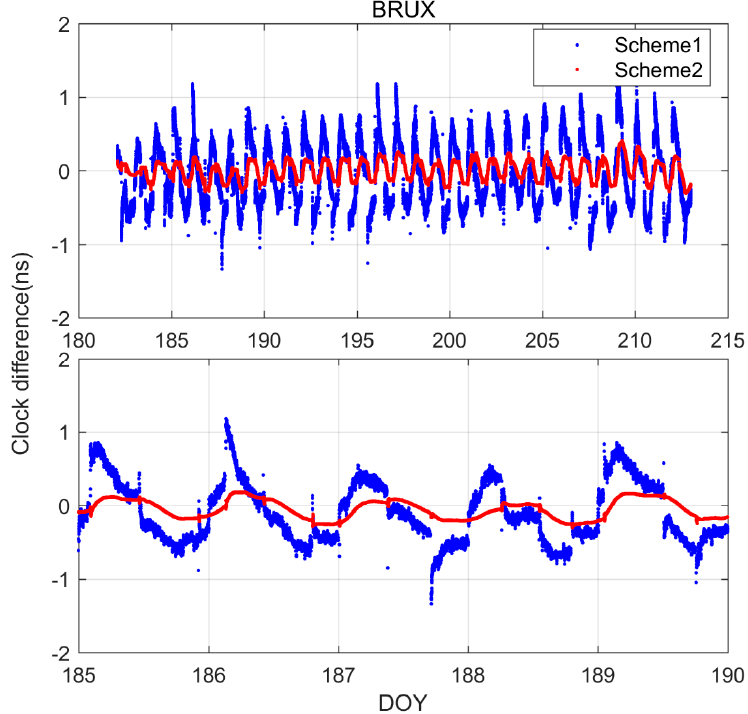
Figure 6. Clock difference time series using scheme 1 ( blue ) and scheme 2 ( red ) with respect to the results of the complete data using the between-epoch constraint model when a data interruption of 10 min occurs; the bottom figure is a partial amplification of the top figure. Table 4. RMS of the clock difference between the solutions obtained with two different schemes with respect to the solutions obtained with the complete data when data interruption occurs (ns).